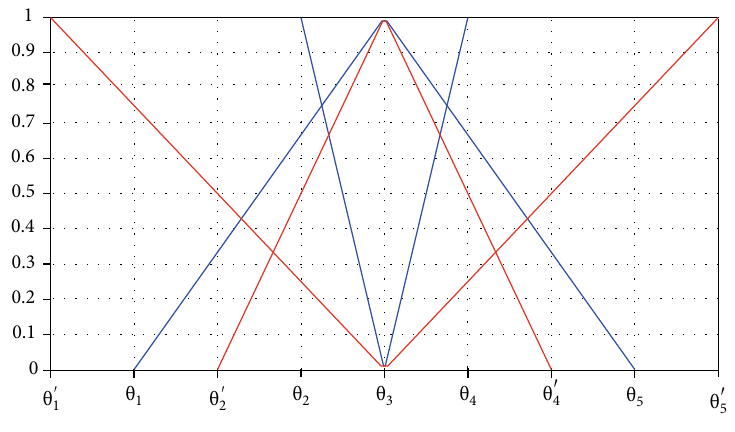
′ , ϑ ′ , ϑ ′ , ϑ ′ Þ . , ϑ 3 1 2 4 5